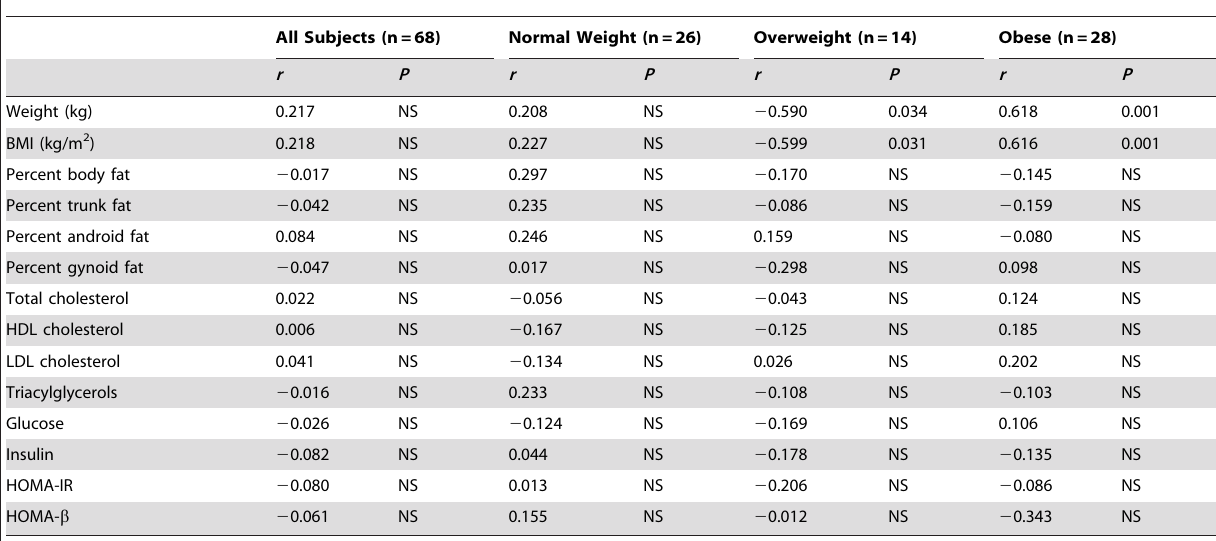
Table 3. Partial correlations of change in variables related to baseline fasting serum ghrelin concentration a,b .